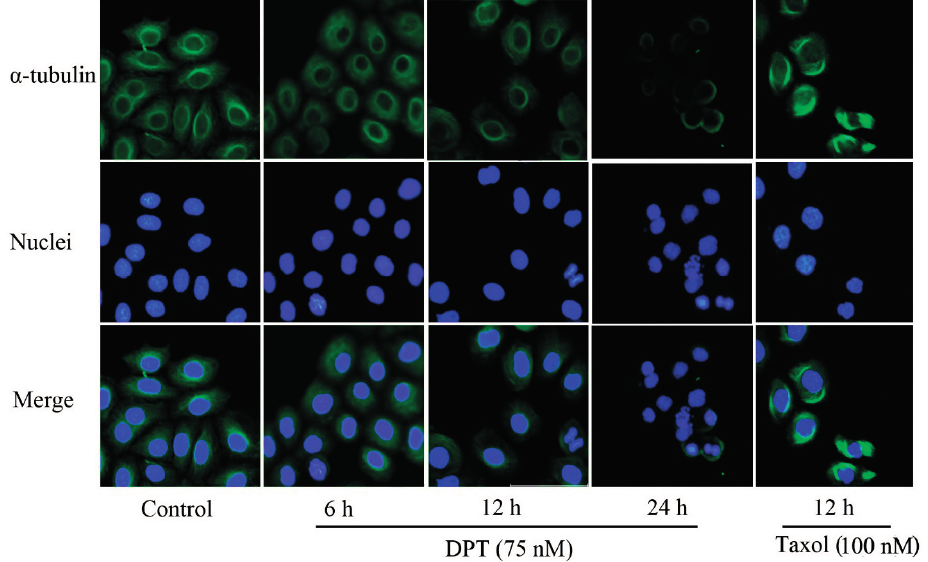
Figure 2. Disruption of microtubule (assembly) in DPT-treated SGC-7901 cells. Cells were treated with 75 nM DPT or 100 nM taxol for the indicated time courses. After fi xation, cells were incubated with anti- α -tubulin antibody followed by Alexa-Fluor 488-conjugated secondary antibody and stained with Hoechst 33342 to visualize DNA (magnification: 200×). In contrast, after DPT treatment for 6 h or 12 h, cells became round and contained short, dense microtubule networks. Cell shrinkage and nuclear fragmentation and condensation were observed after 24 h of DPT-treatment. Taxol resulted in a distinctive microtubule bundles that were likely due to the stabilization of rigid microtubule